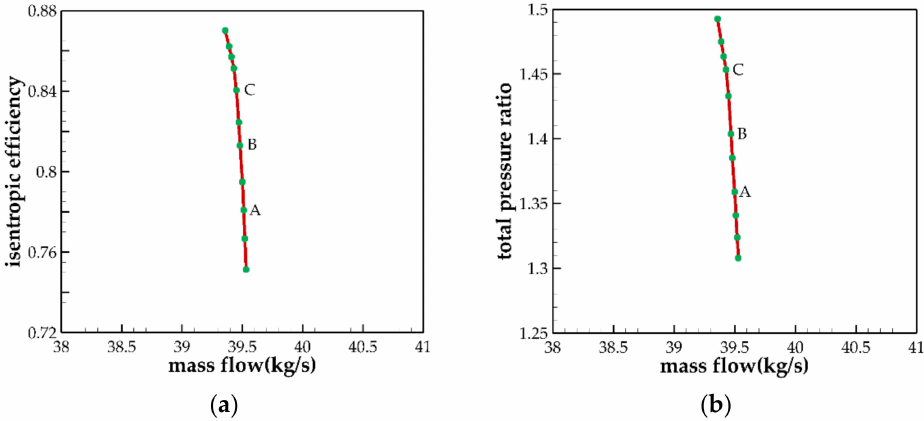
Figure 2. Overall performance of the research compressor. ( a ) Efficiency Characteristic. ( b ) Total Pressure Ratio Characteristic.